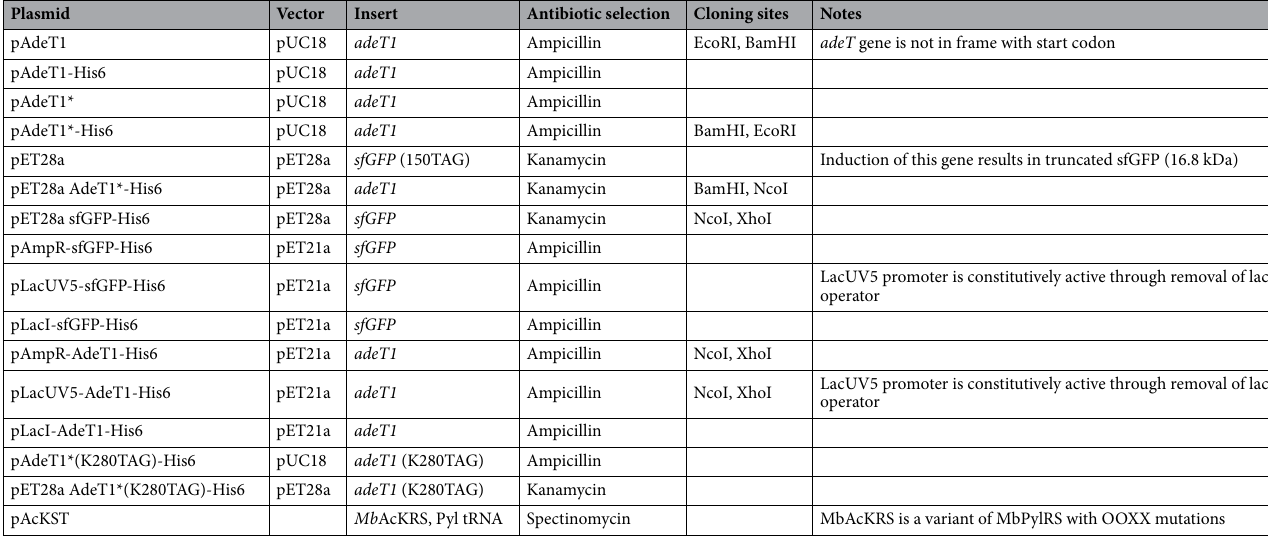
Table 1. Plasmids used in this